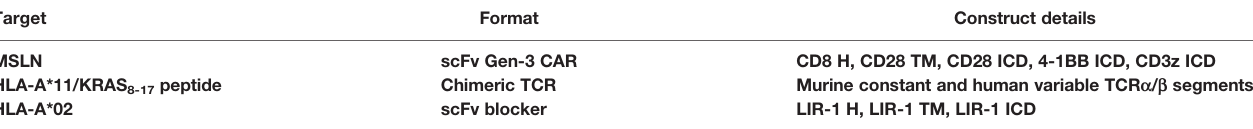
TABLE 1 | Constructs used in